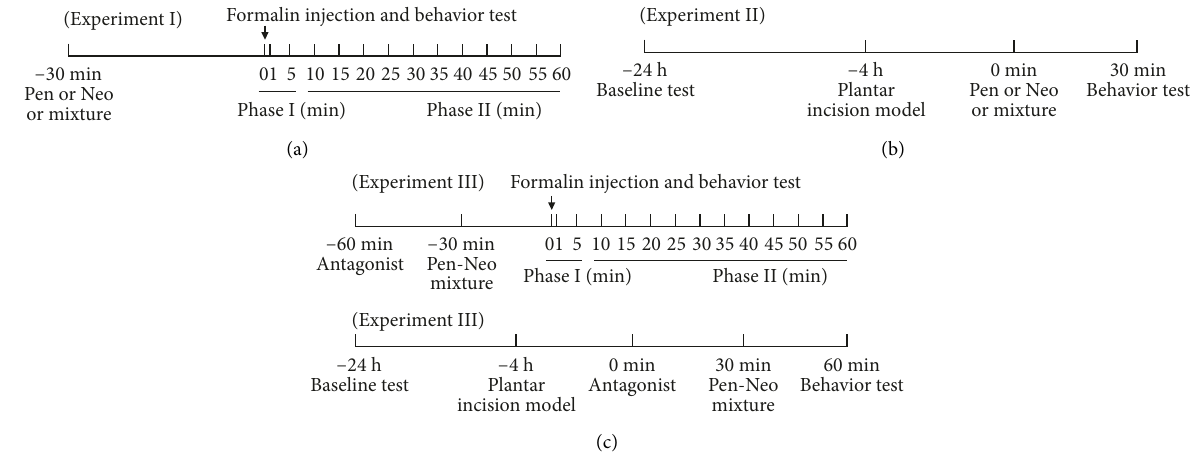
Figure 1: Treatment